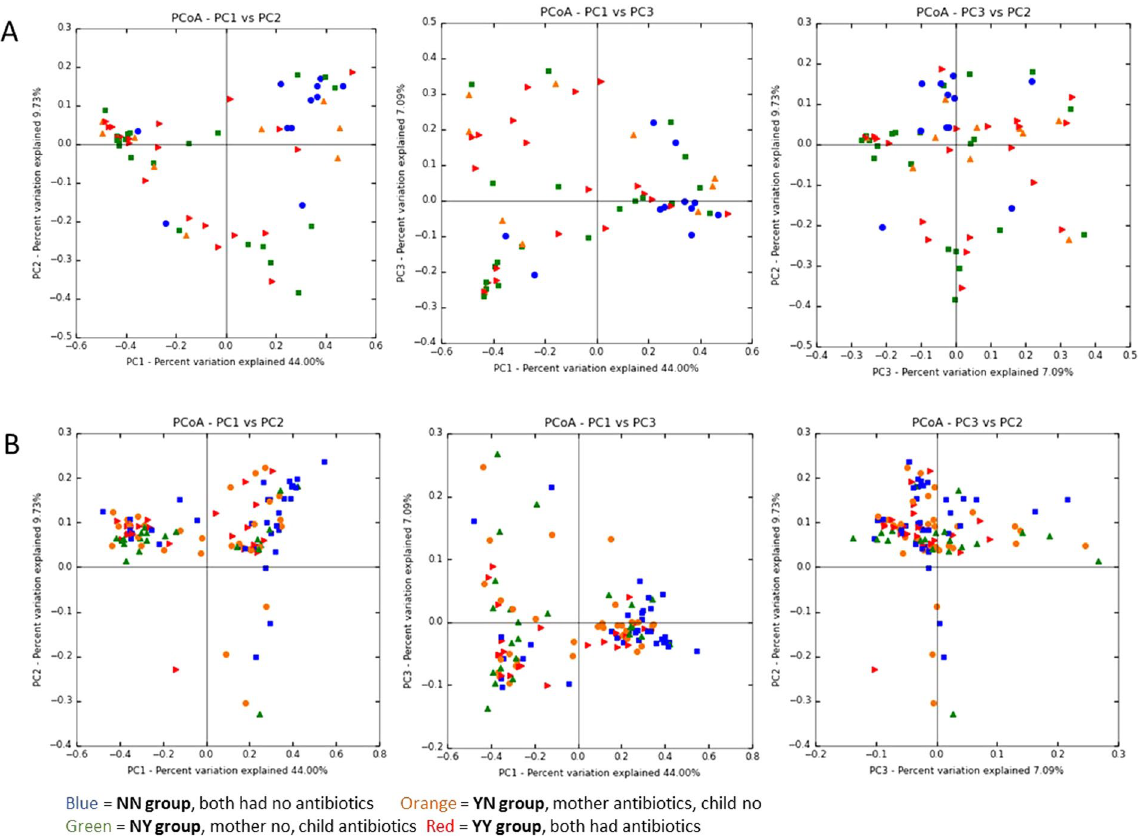
Figure 6. Principal coordinate analysis of fecal microbiota of samples at 96 hours ( A ) and at six months ( B ) according to perinatal antibiotic exposure. Each dot indicates on sample at the selected sampling time. Blue dots indicate NN group (control), orange dots indicate YN group (IAP), green dots NY group (postnatal antibiotics), and red YY group (IAP + Postnatal).